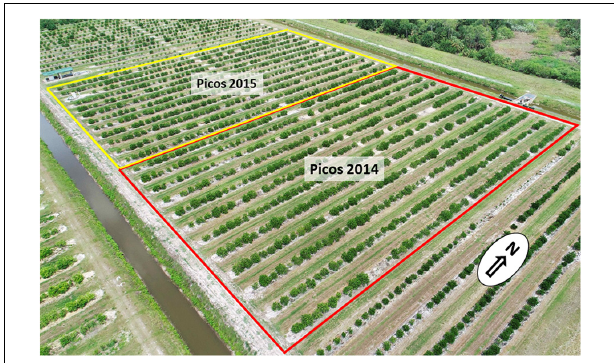
FIGURE 2 | Aerial image in May 2021 of the two rootstock trials with Valencia sweet orange scion, planted with 1287 trees (Photo by R. Niedz).